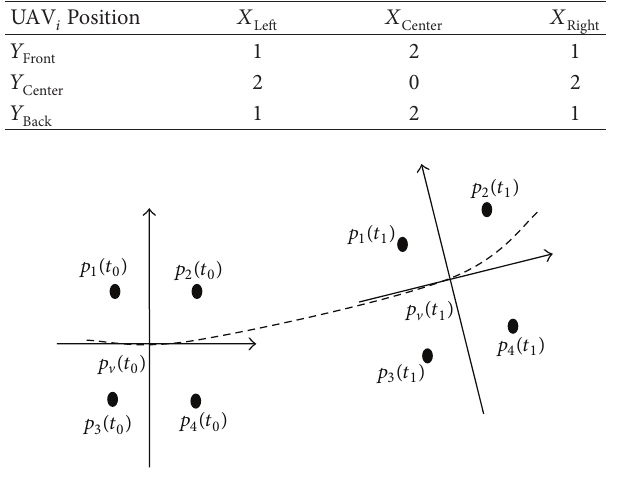
Figure 3: Structure of the center